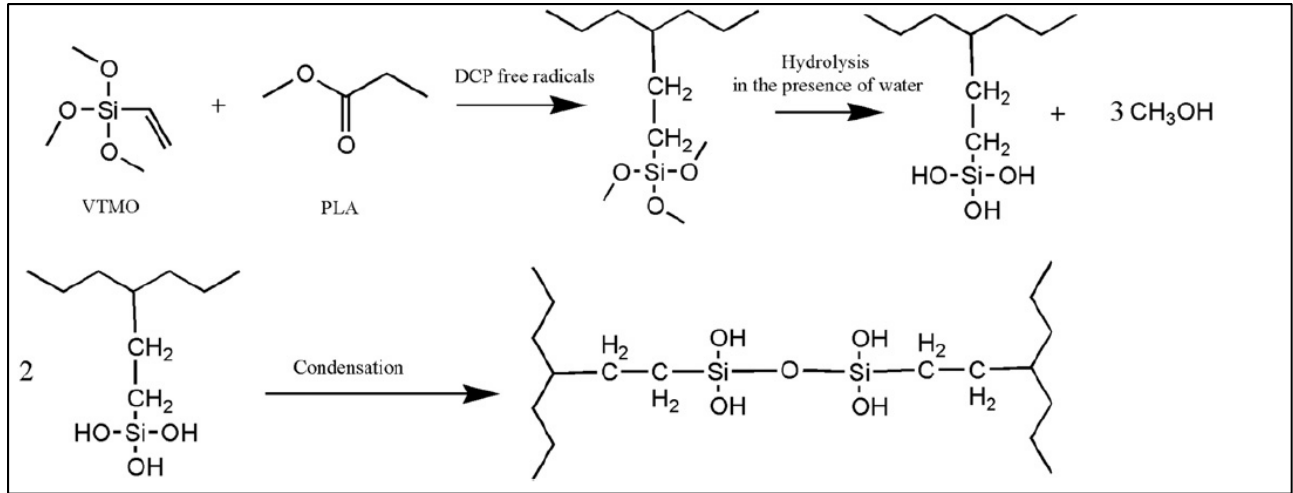
Figure 20. Synthesis scheme of PLA- g -VTMS, hydrolysis of methoxysilane, and crosslinking of PLA chains (adapted from Rahmat et al. [97], copyright Elsevier, reproduced with permission).